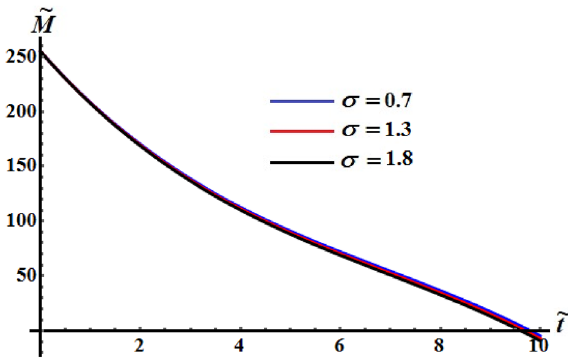
Figure 21. Shows the evolve of ˜ M over time ˜ t at σ ( = 0.7, 1.3, 1.8 ) .